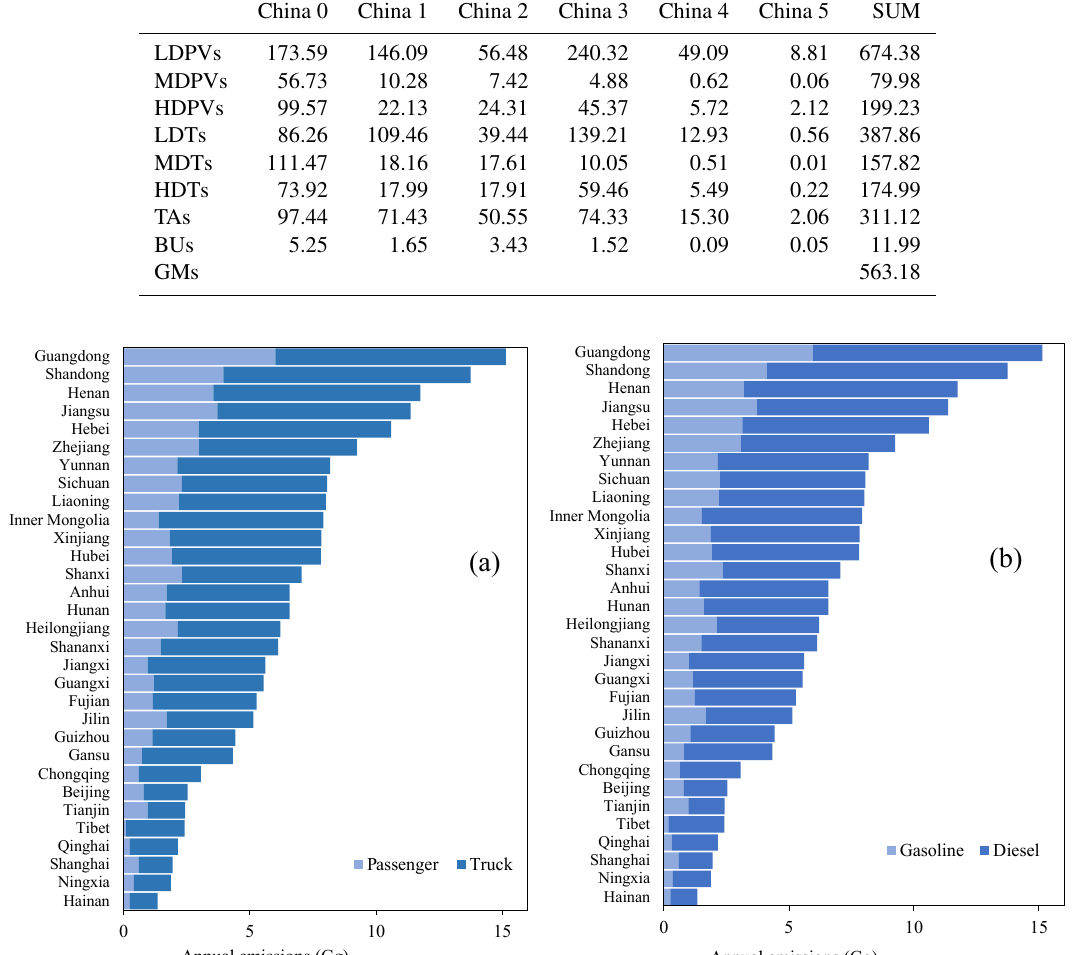
Figure 5. Provincial IVOC emissions from vehicles in 2015: (a) total emission amount classified by vehicle types; (b) total emission amount classified by emission